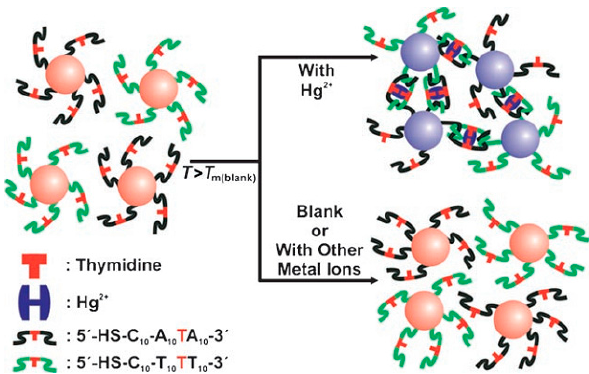
Figure 7. Colorimetric detection of mercuric ion (Hg 2+ ) using DNA–AuNPs. Reprinted with permission from Angewandte Chemie Internaltional Edition, 2007, 46, 4093–4096. Copyright (2007) John Wiley & Sons, Inc.